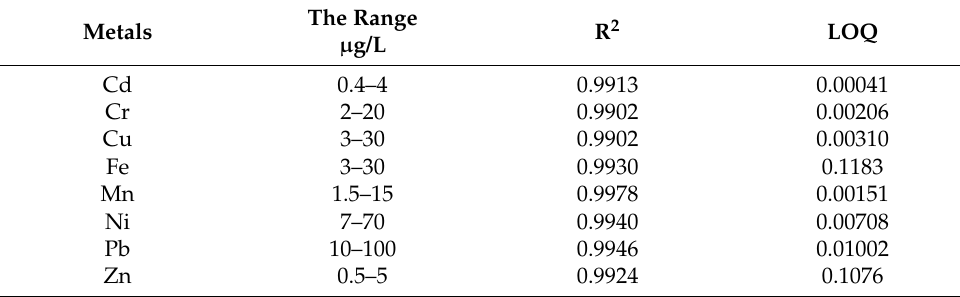
Table 1. Calibration data and quantification